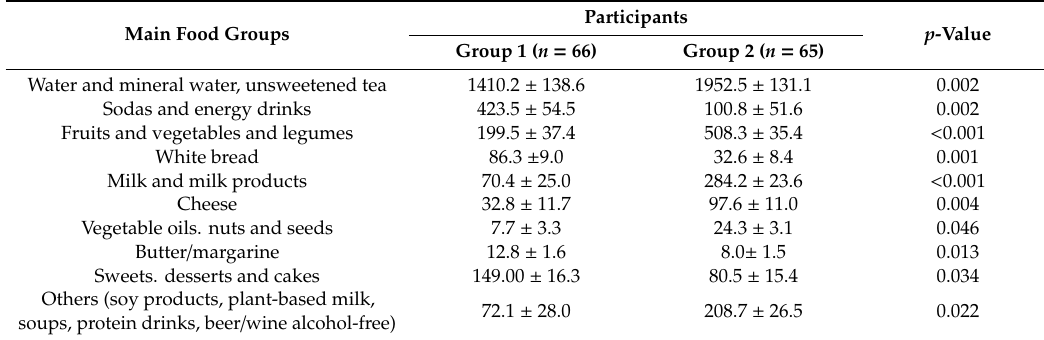
Table 6. Comparison of main food groups contributing to electrolyte intake in participants with adequate electrolyte intake of at least three electrolytes with persons that did not reach reference values in all